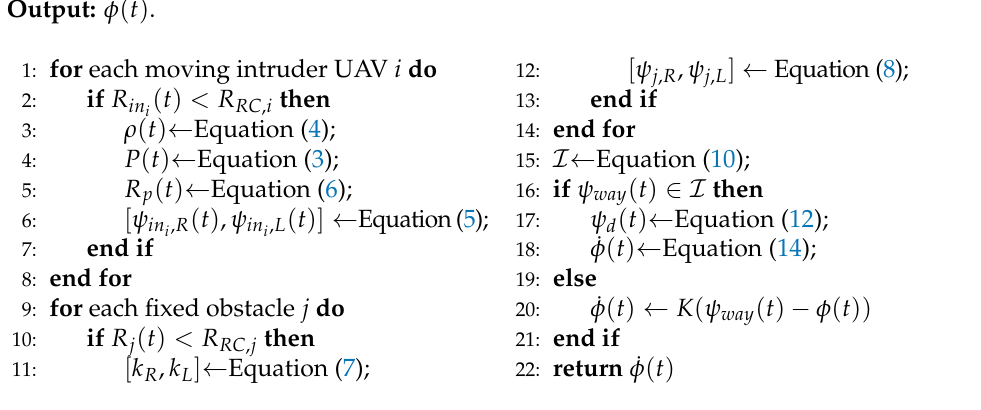
Algorithm 1 Collision Avoidance